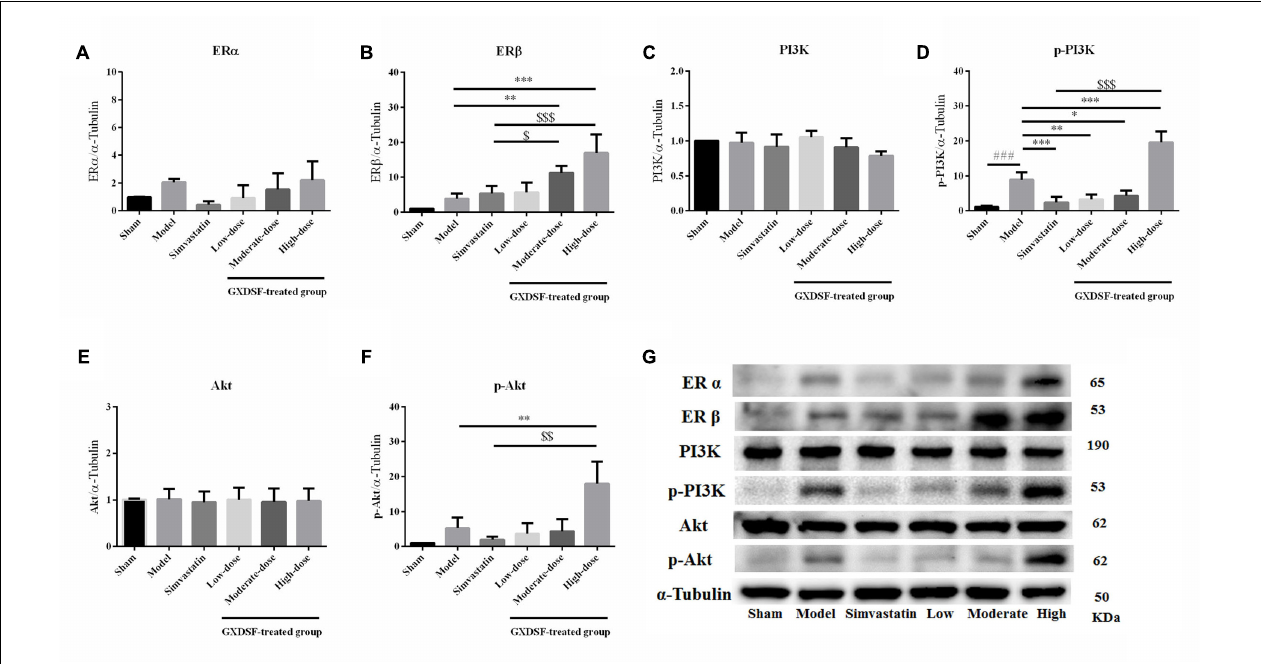
FIGURE 8 | Relative expression of ER α (A) , ER β (B) , PI3K (C) , p-PI3K (D) , Akt (E) , p-Akt (F) and an internal reference ( α –tubulin) (G) in MIRI-LVR rats treated with different doses of GXDSF. Compared with the sham group: ### P < 0.001. Compared with the MIRI-LVR model group: ∗ P < 0.05, ∗∗ P < 0.01, ∗∗∗ P < 0.001. Compared with the simvastatin group: $ P < 0.05, $$ P < 0.01, $$$ P < 0.001. The data are presented as the mean ± SD ( n = 6 in each